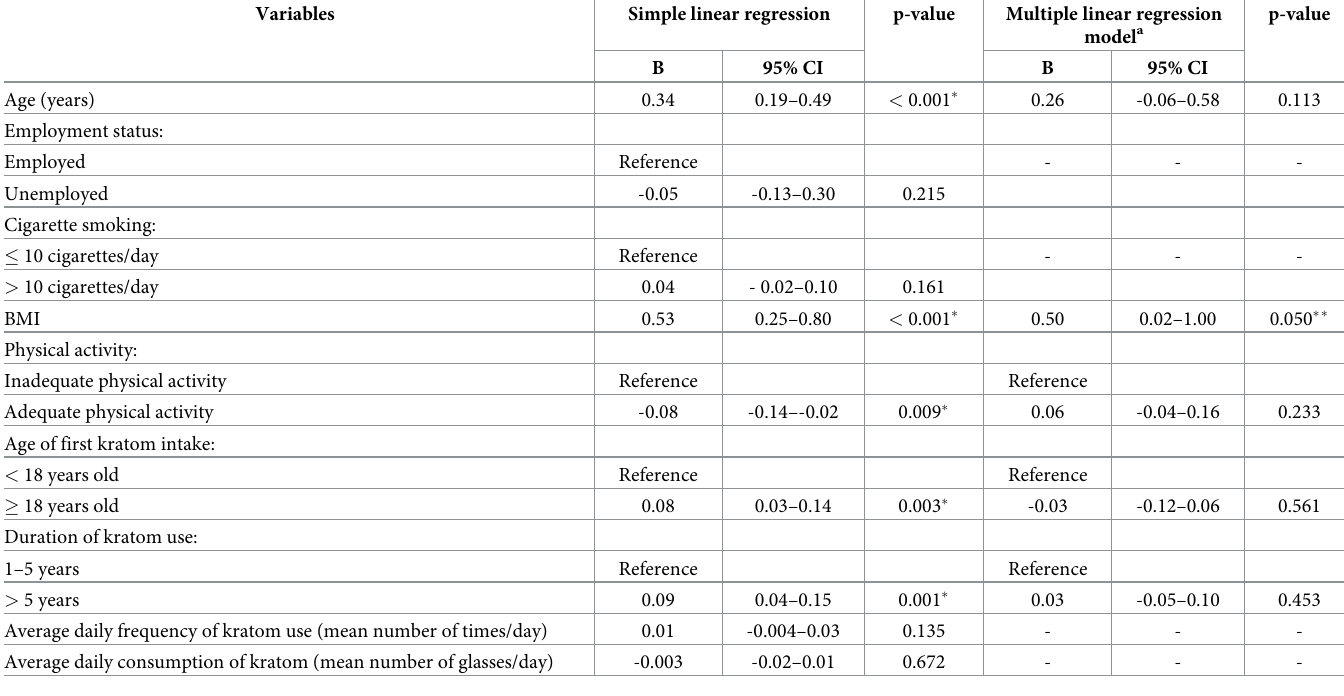
Table 6. Association between kratom use characteristics and serum LDL level among kratom users, accounting for confounding factors such as age, employment status, cigarette smoking, physical activity, and BMI.